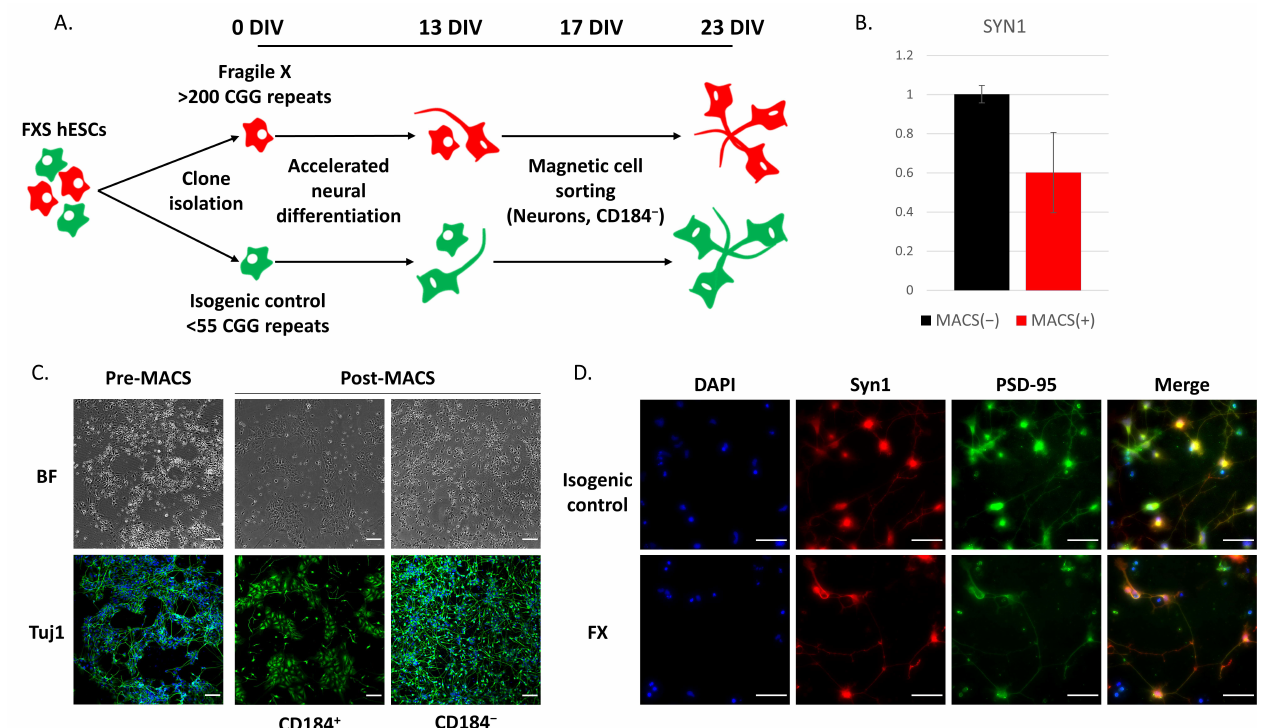
Figure 2. Enrichment of neuronal population following neural differentiation of hESCs. ( A ) Experi- mental scheme of generating FX and isogenic control neurons, differentiation, and magnetic sorting for neuronal enrichment with the cell surface marker CD184. ( B ) RNA expression of synapsin-1 (SYN1) by qRT-PCR at 23 DIV following MACS of isogenic control cells. The positive fraction served as control to normalize the values obtained. The housekeeping gene GAPDH served as an internal control. Three independent biological experiments were performed, and values are presented as mean ± Standard error. ( C ) Neural cells at 23 DIV before and after MACS with CD184. Bright field (BF) and immunofluorescence staining for the neuronal gene Tuj1 (green). Cell nuclei were stained blue by DAPI. Scale bar: 100 µ m. ( D ) Immunofluorescence staining of FX and its isogenic control cells following in vitro neural differentiation and neuronal enrichment, for SYN1 (red) and for the postsynaptic density protein 95 (PSD-95; green). Cell nuclei were stained blue by DAPI. Scale bar: 50 µ